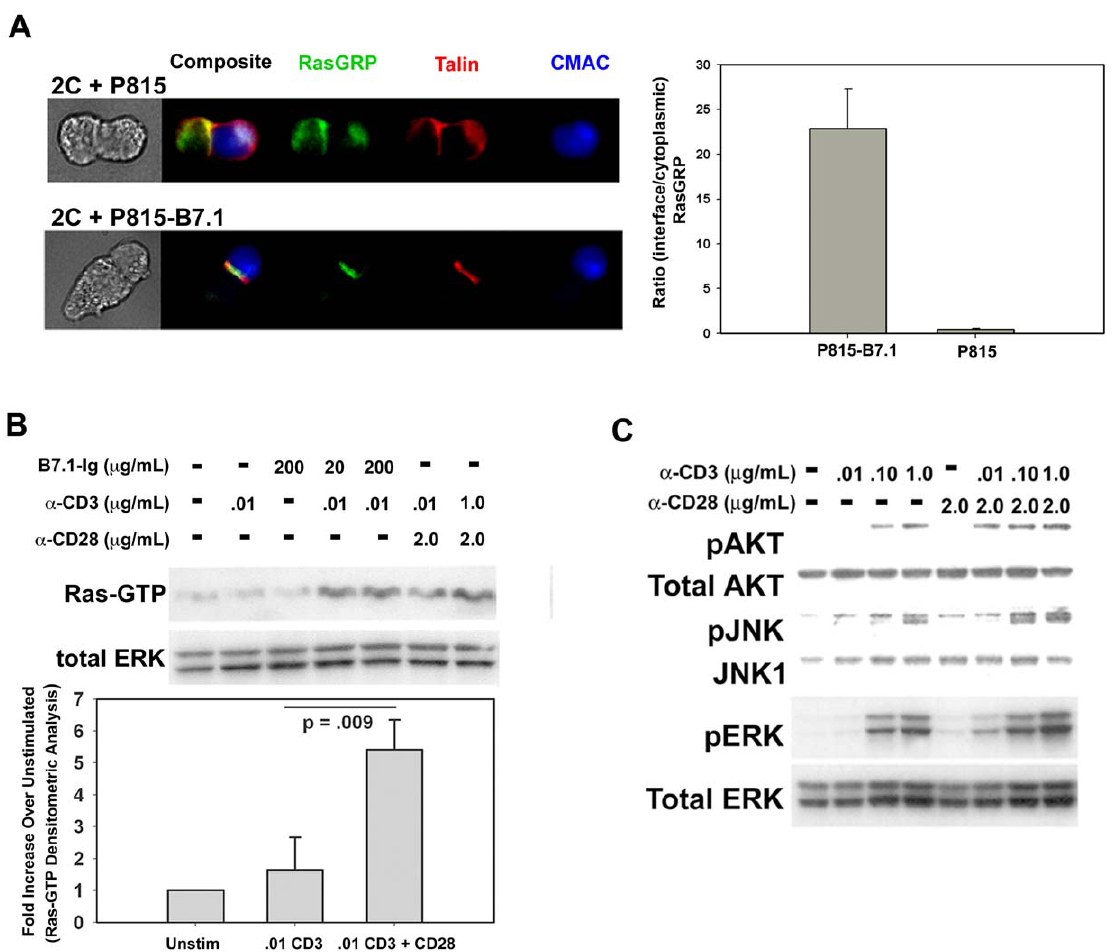
Figure 1. CD28-mediated costimulation relocalizes and augments Ras activation. A. Splenic CD8 + T cells from 2C TCR transgenic mice were primed in vitro as described [15] to generate effector cells. They were then incubated with CMAC-labeled P815 or P815-B7.1 tumor cells (expressing a ligand for the 2C TCR). Conjugates were stained for RasGRP and Talin and analyzed by confocal microscopy (left). Statistical analysis of T cell RasGRP localization was done by measuring the ratio of the average pixel intensity of RasGRP staining at the T cell-APC interface to the average pixel intensity of RasGRP staining in the T cell cytoplasm. Analysis of at least 100 conjugates per experiment demonstrates a significant relocalization of RasGRP to the T cell-APC interface when CD28 costimulation is added to P815 stimulation (p , 0.05, right). See materials and methods for details of image analysis and criteria used to definine T-cell APC conjugate, T cell-APC interface and T cell cytoplasm. Error bars indicate the standard deviation of the mean pixel intensity ratios (interface/cytoplasm) under the two indicated conditions from the same experiment. B. CAR Tg Th1 T cells were stimulated with beads coated with anti-CD3 antibody alone, or with anti-CD3 plus either anti-CD28 or B7.1-Ig fusion protein for 30 minutes. Cellular lysates were analyzed for Ras activity as described in Materials and Methods (top). Ras activation was quantified using densitometric analysis of western blots to determine the fold-increase in RasGTP-generation above unstimulated cells (bottom). Error bars represent the standard deviation in mean Ras activation for a given stimulation condition between replicate experiments. The p-value indicated in the figure demonstrates a significant difference in Ras-GTP generation when CD28 costimulation was added to CD3 stimulation. C. CAR Tg Th1 cells were stimulated as in A with increasing doses of anti-CD3 (0.01–1 m g/mL) with or without anti CD28 (2 m g/mL) and analyzed for phosphorylated AKT, JNK, and ERK by western blotting.